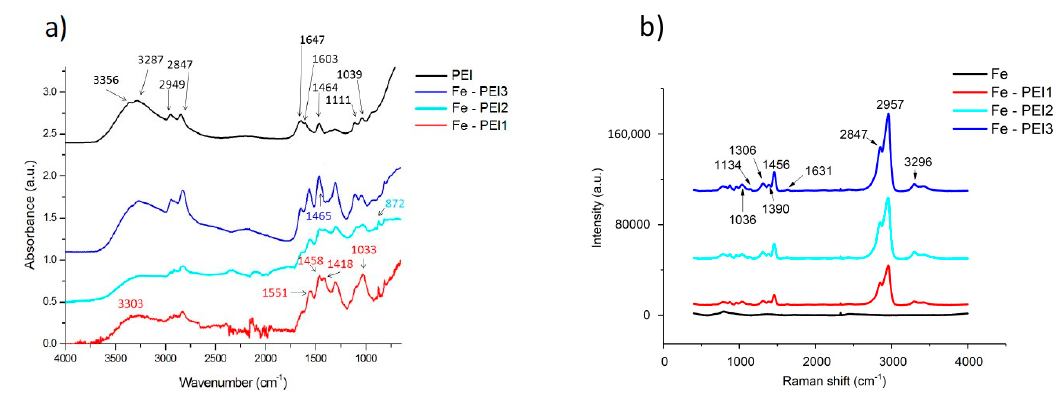
Figure 5. The spectra of pure iron and PEI coated scaffolds recorded using ( a ) FT-IR and ( b ) Raman spectroscopy.